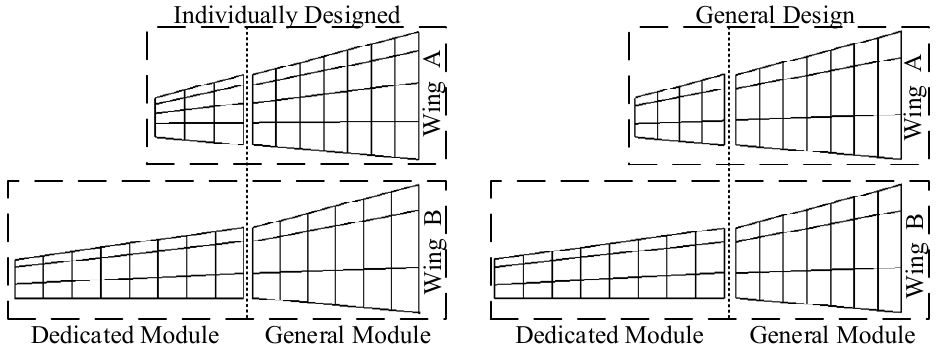
Figure 1. Modular structure layout optimization problem.